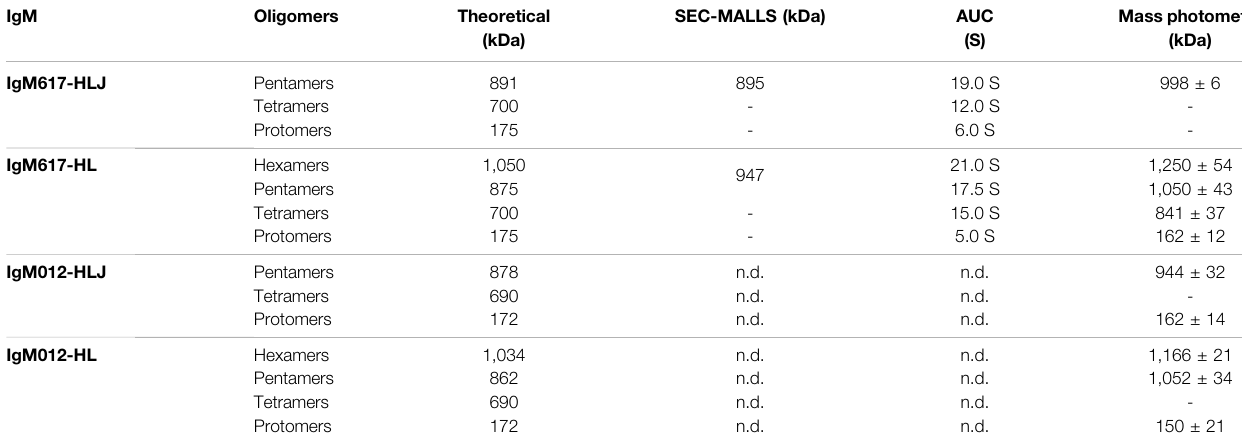
TABLE1| Summaryoftheoreticalandexperimentalmolecularweightsandofsedimentationcoef fi cients.Thetheoreticalpeptidemolecularweightsarecalculatedbasedon the amino-acid primary sequences of the subcloned IgM chains using Protparam (Gasteiger et al., 2005). Experimental molecular weights were determined by SEC- MALLS and MP and sedimentation coef fi cients by AUC.